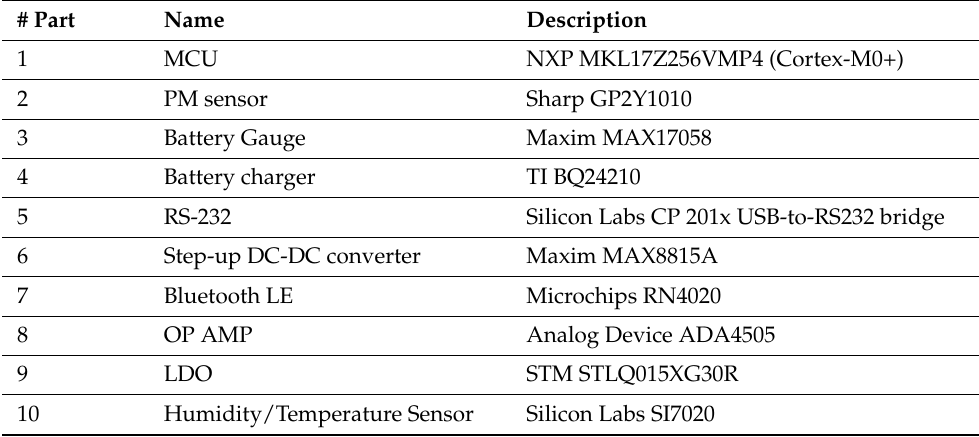
Figure 1. PM sensing system: ( a ) block diagram and ( b ) appearance. Table 1. Part list used in the